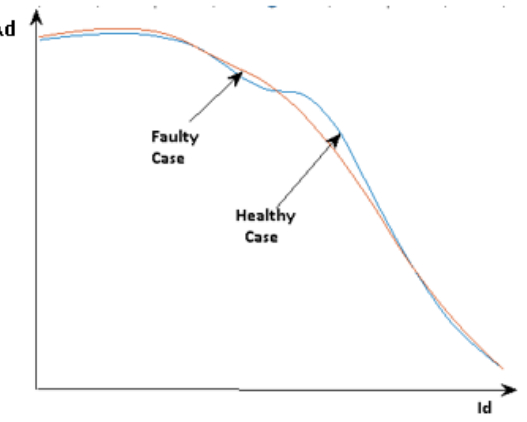
Figure 3. Shift in peak of incremental inductance curve due to static eccentricity